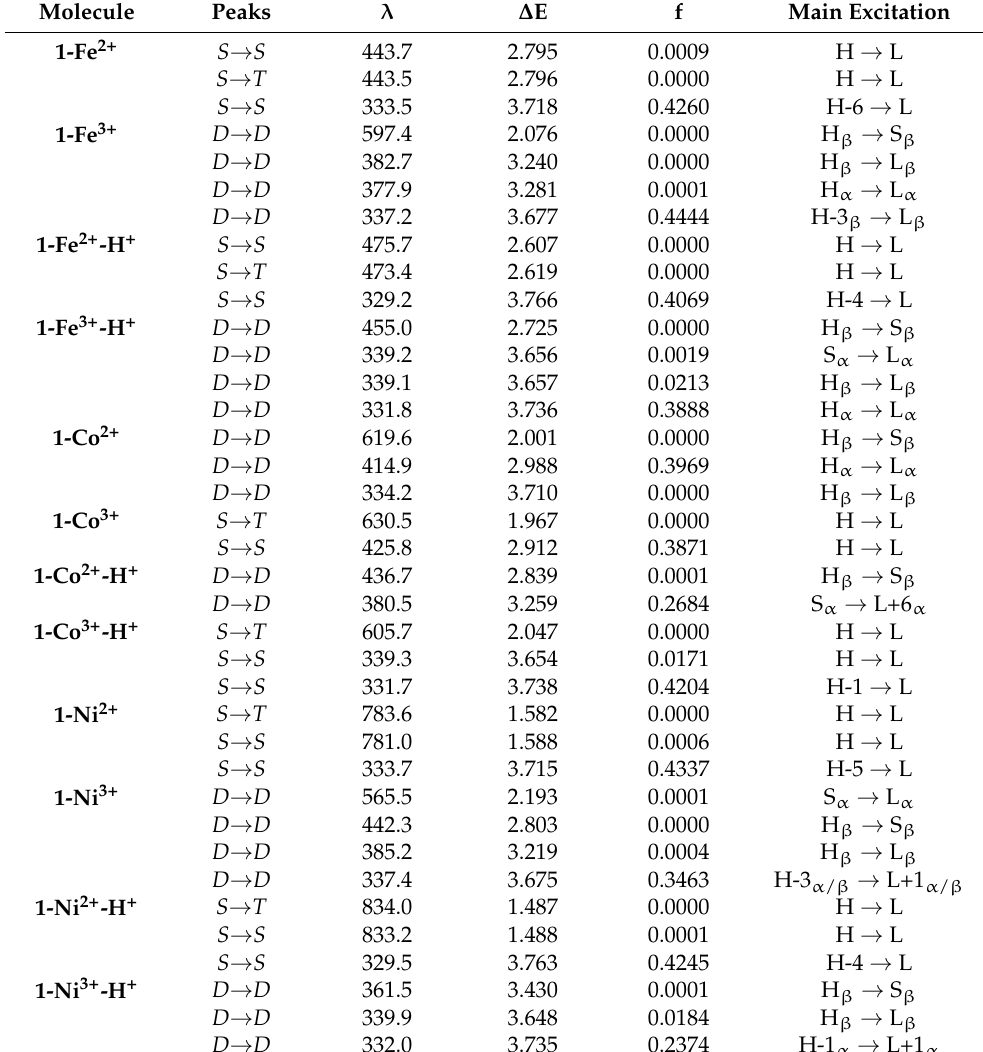
Table 3. Absorption maxima and charge transfer peaks, λ (nm), energy differences, ∆ E (eV), of S 0 → S x , S 0 → T 1 and D → D, f-values, and the corresponding main excitations of the absorption spectra of